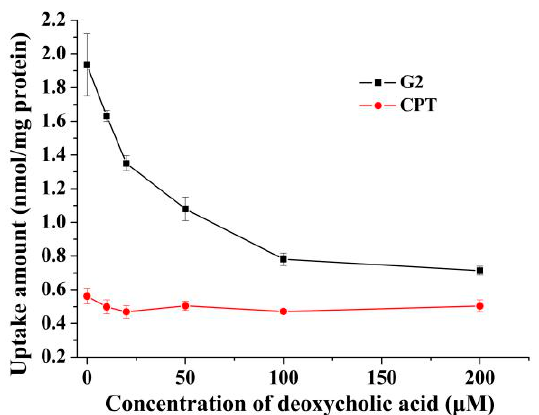
Figure 4. The effect of deoxycholic acid on uptake of G2 and CPT in HepG2 3D cell model. After pretreatment with different concentrations of deoxycholic acid for 0.5 h, spheroids were incubated with 10 µ M G2 or CPT for 2 h and the amount of uptake was detected. Results are presented as mean ± SD of three independent measurements.